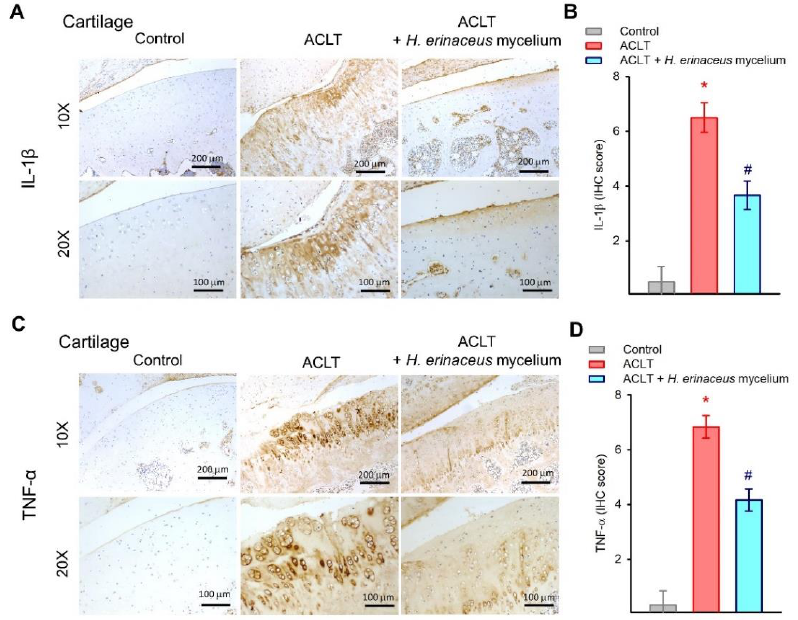
Figure 5. H. erinaceus mycelium suppresses IL- 1β and TNF - α expression in the cartilage. ( A , C ) Rep- resentative images of IL- 1β and TNF - α staining. ( B , D ) Quantification of IHC scores ( n = 6 for each